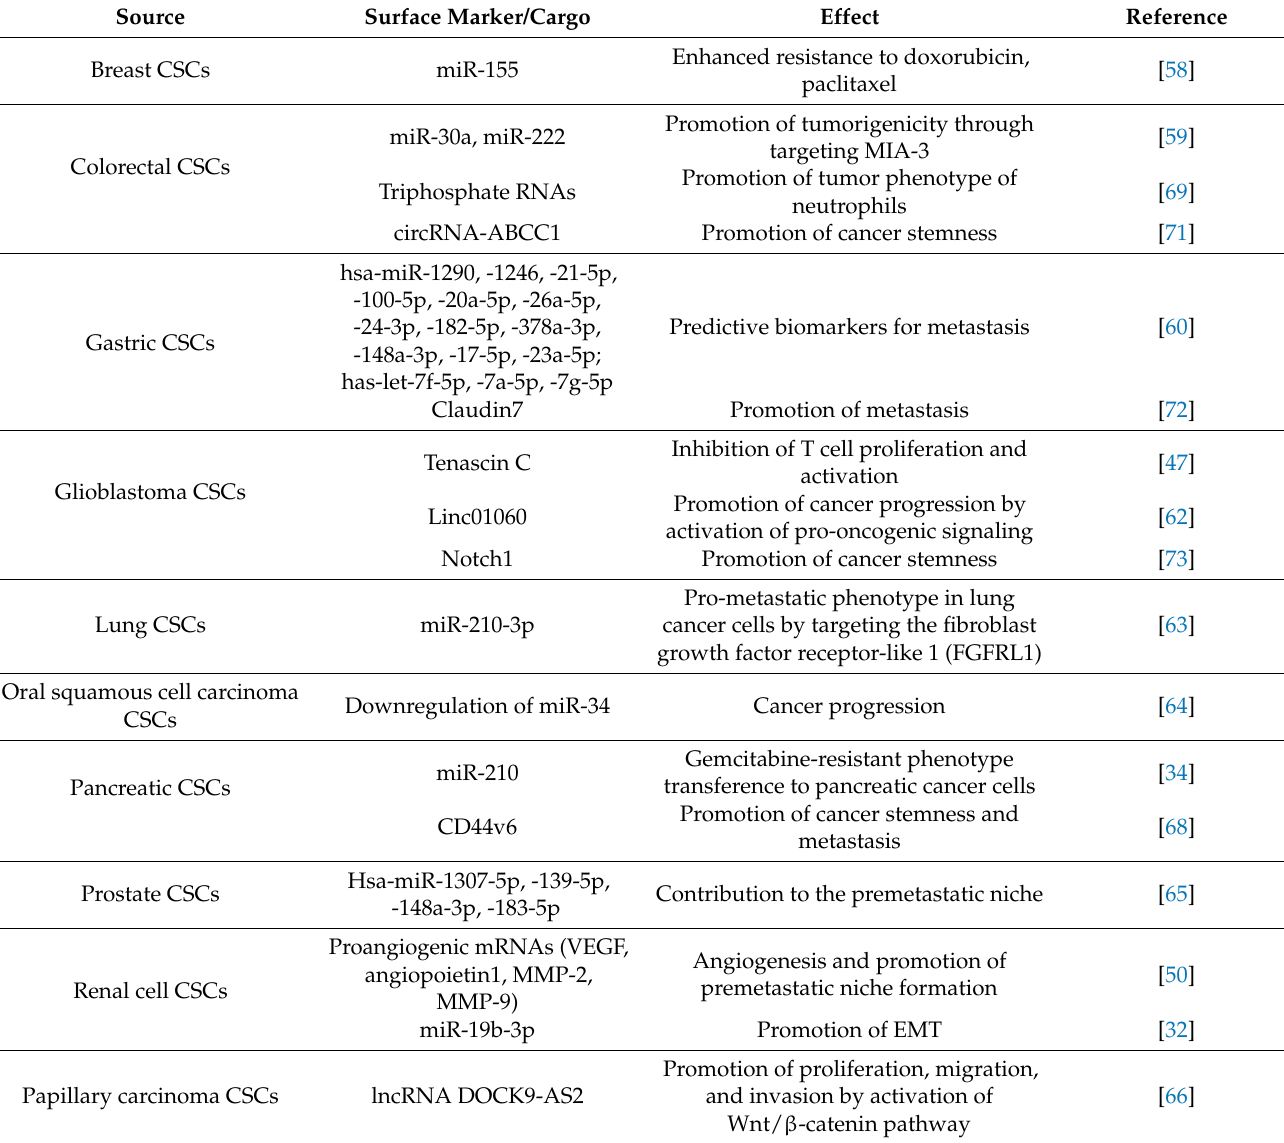
Table 1. Functions of surface markers/cargo found in tissue-specific cancer stem cell-derived exosomes